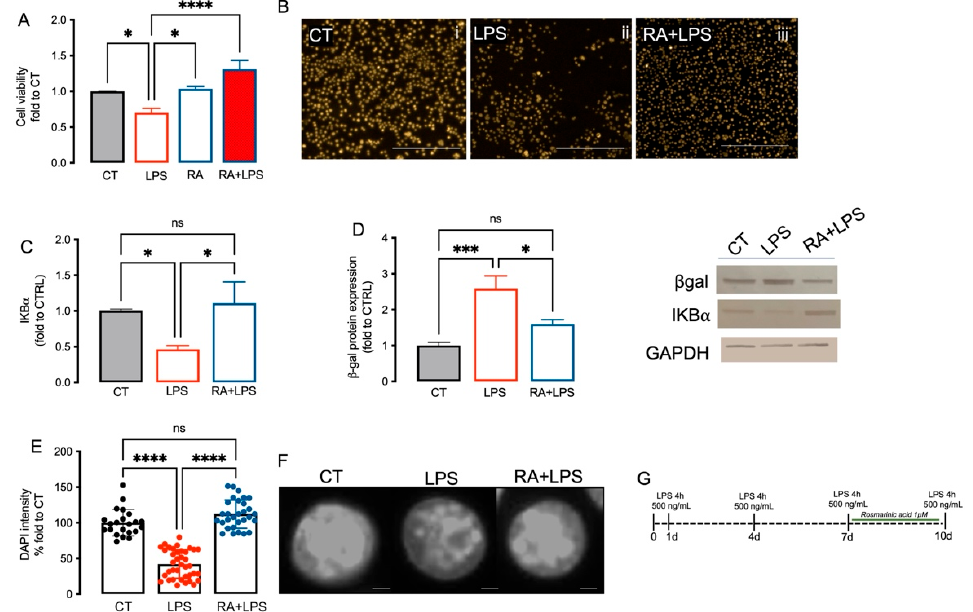
Figure 2. Evaluation of the effect of rosmarinic acid (RA) on microglial senescence. ( A ) Effect of RA 1 µ M on cell viability. ( B ) Representative images of cell viability of untreated BV2 cells ((i); CT), senescent microglia ((ii), LPS) and pretreated-senescent BV2 cells ((iii), RA + LPS). Scale bar 200 µm). ( C ) IkB α protein expression. ( D ) ß-galactosidase (ß-gal) protein expression. ( E ) formation of SAHF in BV2 senescent cells at 10 days. Dots are the number of nuclei counted. One-way ANOVA **** p < 0.0001 *** p < 0.001, * p < 0.05 ( n = 3). ( F ) Representative images of DAPI intensity. Scale bar 2 µm. ( G ) Schematic representation of the experimental protocol adopted in the neuroinflammation model. Representative blots are reported ( n = 3). ns = not significant.